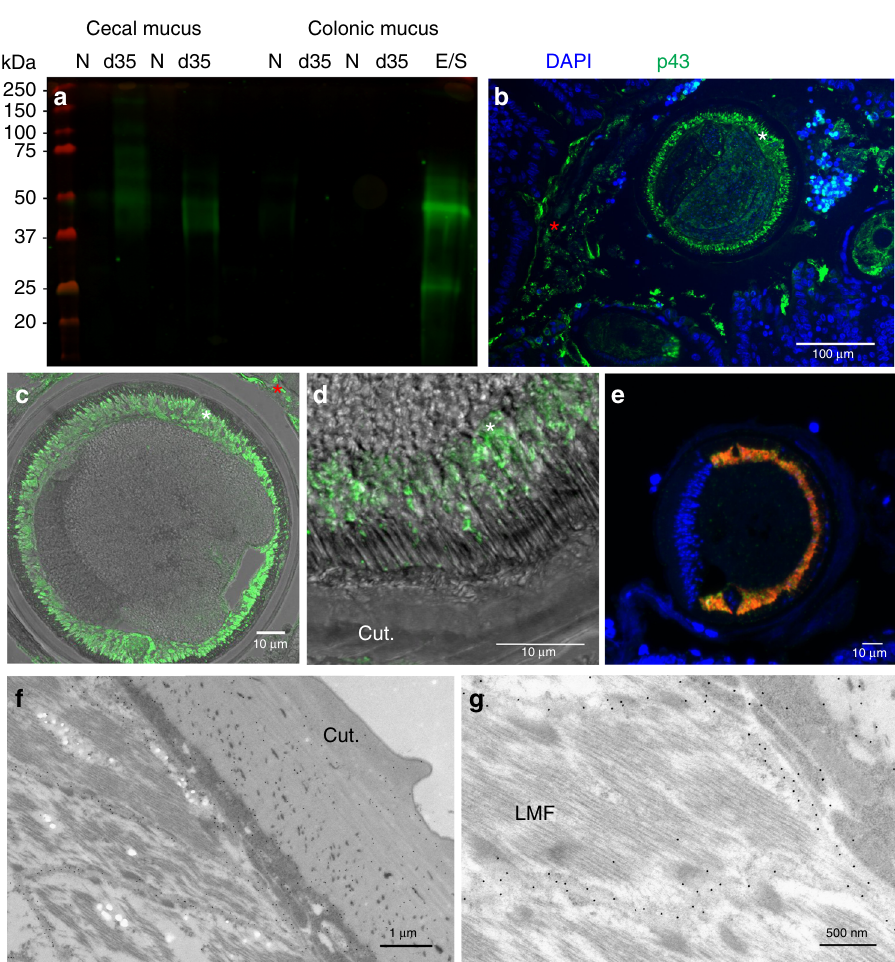
Fig. 1 p43 is associated with the longitudinal muscle of the parasite and the intestinal mucus and the surrounding epithelial matrix of the host. a Western blot of cecal and colonic mucus samples from naive (N), Trichuris muris- infected (d35) mice, and T. muris whole excretome/secretome (E/S) probed with anti-p43 antibody. b Cecal sections from infected mice stained with anti-p43 and 4 ′ ,6-diamidino-2-phenylindole, dihydrochloride (DAPI) (merged), demonstrating staining within the worm (white asterisk) and extracellularly within the host intestinal lumen (red asterisk). c , d Transverse section of a worm taken from cecal sections from infected mice stained with anti-p43. d p43 staining within the worm (merged with bright fi eld). e Transverse section of an adult T. muris hybridized with a p43 Cy5 probe (red) and myosin fl uorescein isothiocyanate (FITC) probe (green); a merged image is shown, counterstained with DAPI. f , g Electron micrograph of adult T. muris stained with anti-p43 and colloidal gold particle-conjugated secondary antibodies. (Cut. = cuticle; LMF = longitudinal muscle fi bers; white asterisk = within the worm; red asterisk = within the host intestinal